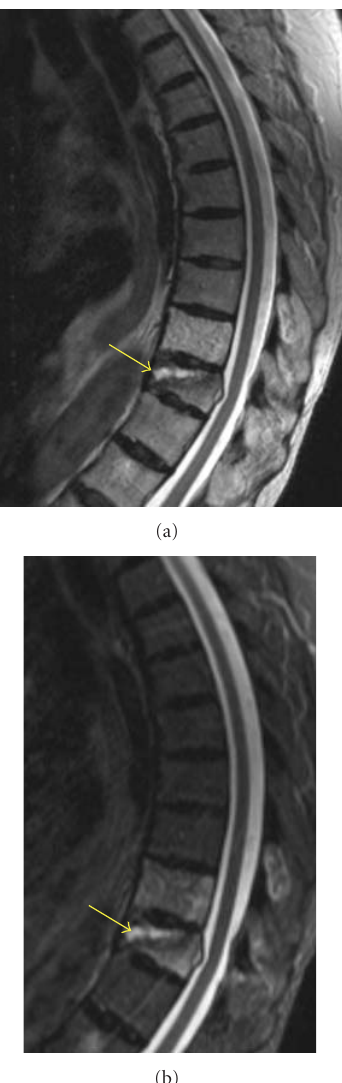
Figure 10: Sagittal T2-weighted (a) and STIR (b) MR images reveal abnormal hyperintense signal in a lower thoracic vertebral body due to fracture-related edema. A “fluid sign” is demonstrated in this vertebral body (yellow arrow), which is characteristic of a benign osteoporotic